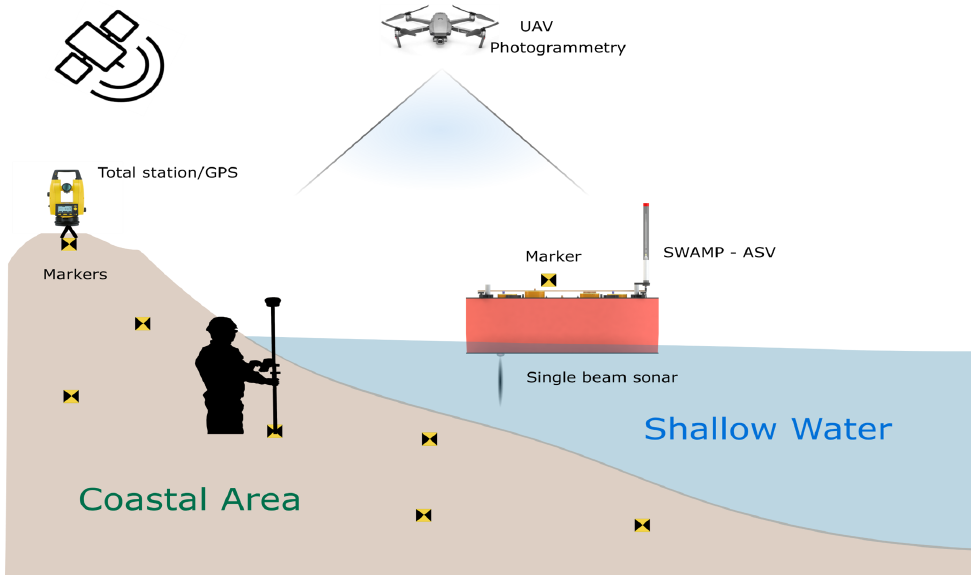
Figure 3. Interdisciplinary approach by using several techniques to perform integrated survey campaign over different environments (emerged and submerged